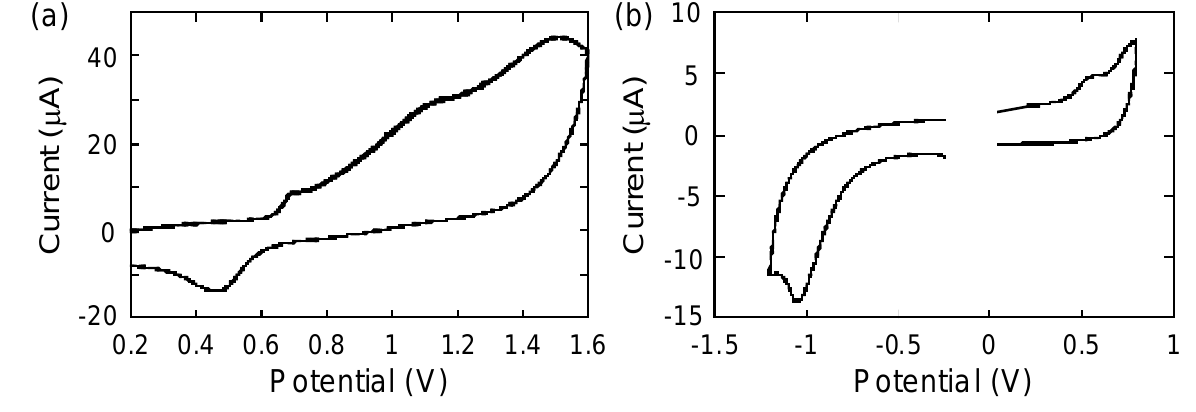
Figure 5. Cyclic voltammograms of ( A ) P1 and ( B ) P2 in CH